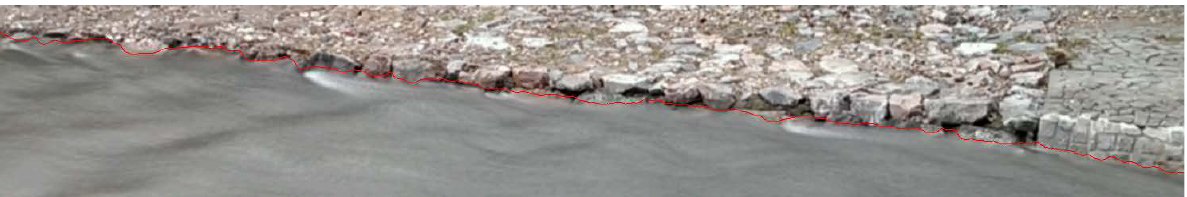
Figure 8: Densified detected waterline (red); Background image: average of co-registered image